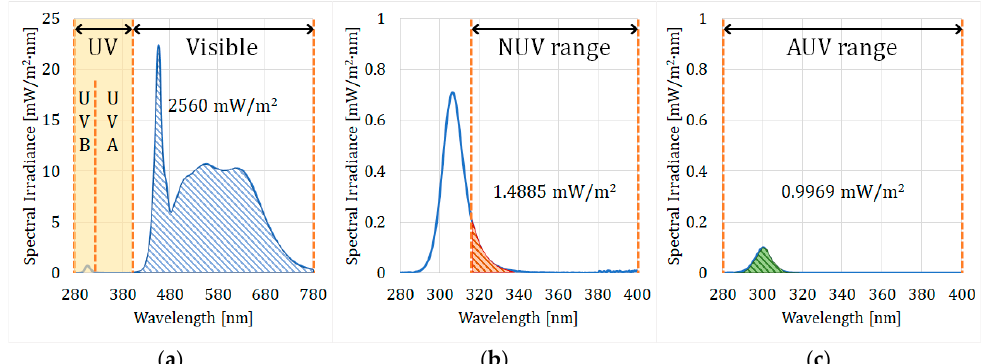
Figure 8. Measurement results of the UVB LED general lighting using a spectrometer (CAS 140 CT-152, Instrument Systems). ( a ) Spectral irradiance of the proposed lighting; ( b ) spectral irradiance of UV region and Near UV (NUV) irradiance; ( c ) spectral irradiance of UV region with actinic hazard weighted and Actinic UV (AUV) irradiance.